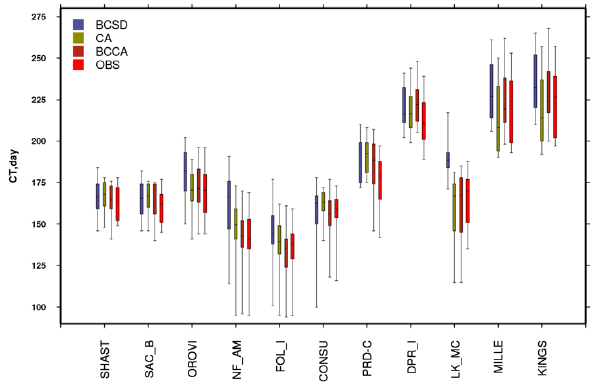
Figure 5. Center timing for each streamflow site using each downscaling method, and the 2 Fig. 5. Center timing for each streamflow site using each down- scaling method, and the observationally-derived streamflows. Day observationally-derived streamflows. Day is day of the water year, so 1 corresponds to 3 is day of the water year, so 1 corresponds to 1 October 1. 4 5